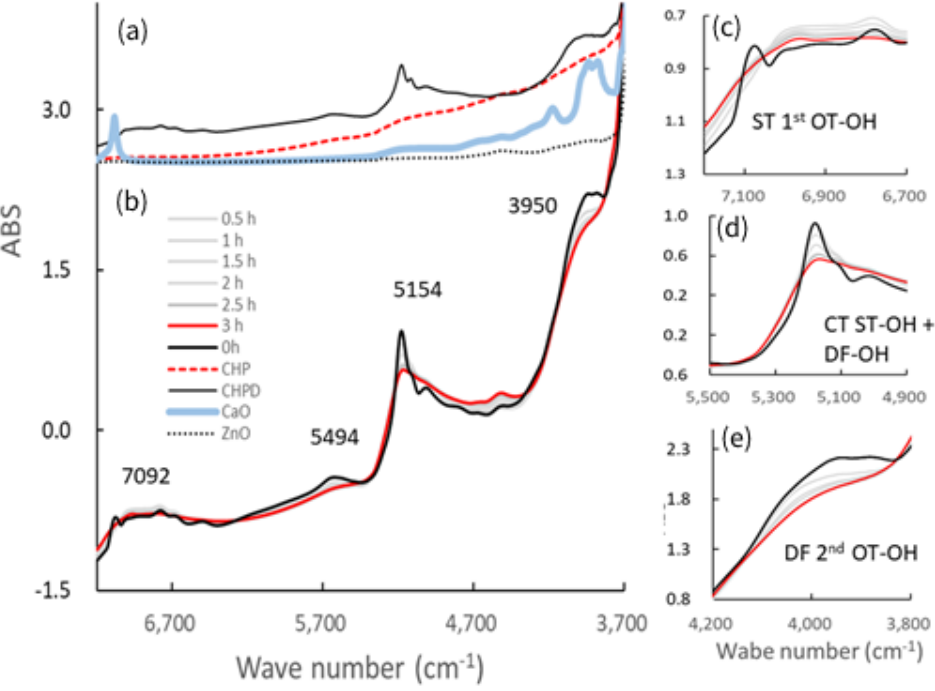
Figure 5. Near-infrared (NIR) spectra of the ground S-CP products obtained at various grinding times and their pure starting materials. ( a ) NIR spectra of each original starting material; ( b ) change in the spectra of the S-CP consisting of CHPD, CaO, and ZnO (20:7:3) during wet grinding; NIR spectra at wavelengths of approximately ( c ) 7000, ( d ) 5000, and ( e ) 4000 cm − 1 . OT, overtone; DF, deformation vibration; ST, stretching vibration; CT, combination tone.